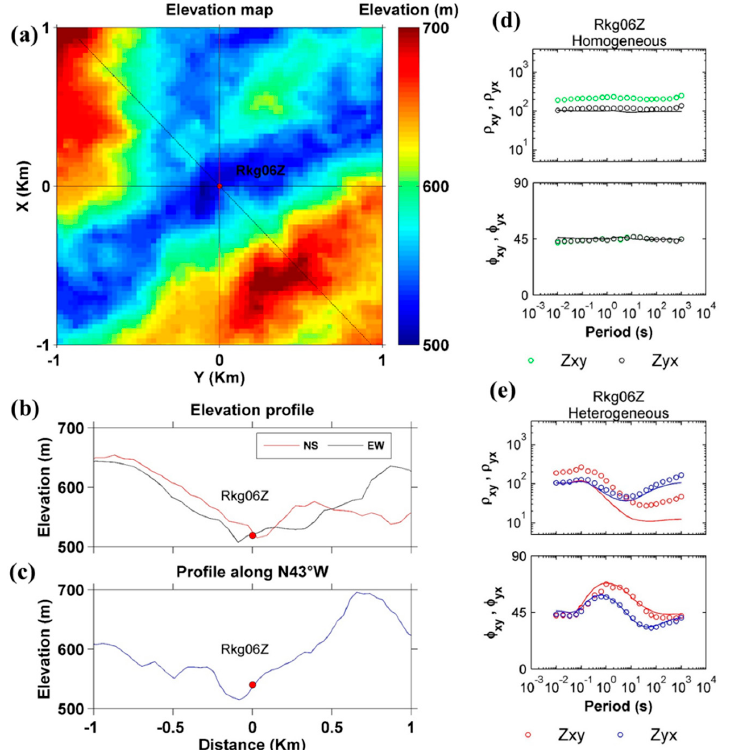
Figure 8. ( a ) The elevation map around site 06. ( b ) Elevation profile along the NS, EW and the direction of maximum elevation change ( c ). ( d ) The comparison of MT response of off-diagonal components generated by ( d ) homogeneous half-space model and ( e ) heterogeneous model. Site 14 is located further north, in the north of the SH zone near the MBT, at 1042 m elevation. The elevation and slope vary from 796 to 1422 m and from -49° to +19°, respec- tively, within 1 km from this site. The topographic variations along the NS and EW direc- tions are shown in Figure 9b. The site is influenced by a hill and topographic effects in off- diagonal components of responses, as shown in Figure 9d. A constant downward shift in the entire period range, but with different magnitudes in two off-diagonal components, indicates the dominant galvanic effects.